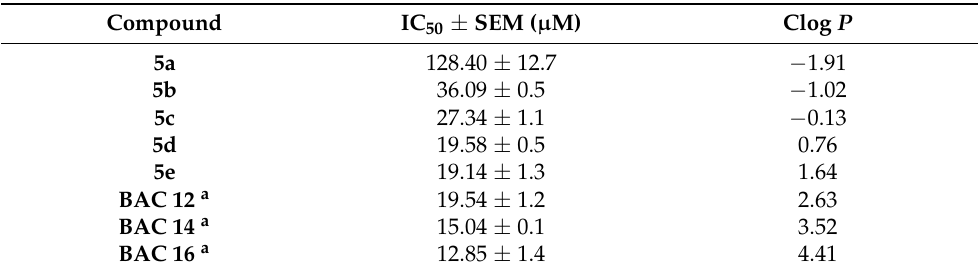
Table 5. The effect of the tested compounds on CHO-K1 cell viability. Values are expressed as the IC 50 (series 5a-e ): Mean ± SEM ( n =